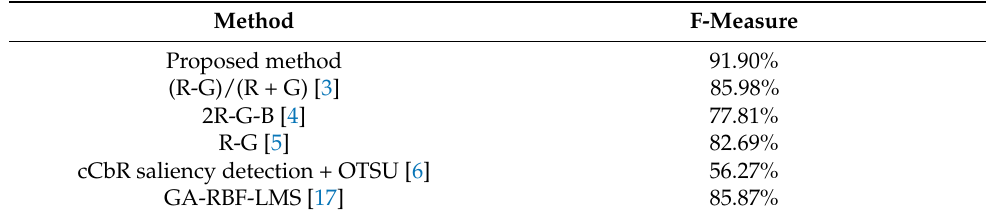
Figure 9. Comparison of segmentation results by six methods under different conditions. ( a ) individual apple in abundant light; ( b ) overlapped apples in abundant light; ( c ) overlapped apples under low-light condition; ( d ) few apples under low-light condition Table 2. Comparison of F-measure for six